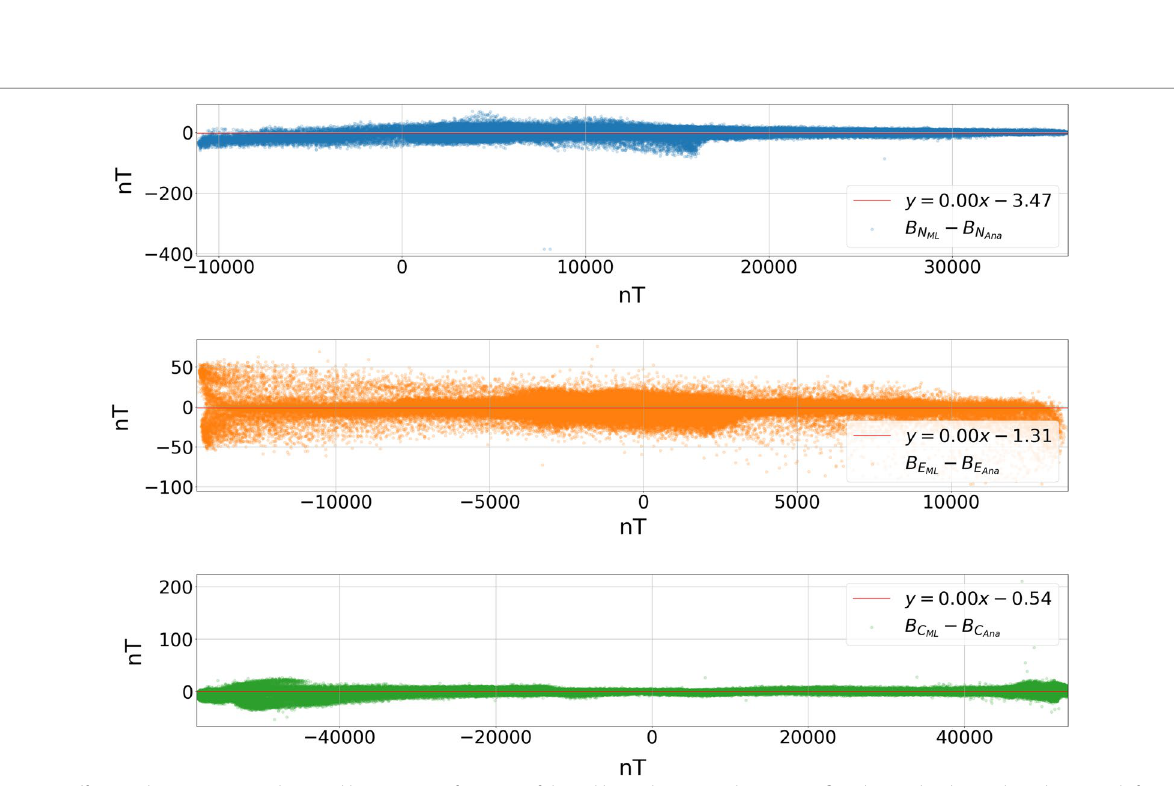
Fig. 8 Difference between ML and Ana calibrations as a function of the calibrated measured magnetic flux density by the analytical approach for the December of 2009 for the North (top), East (middle) and Center (bottom) component. The regression curves are given in red. Please note the different scales of the